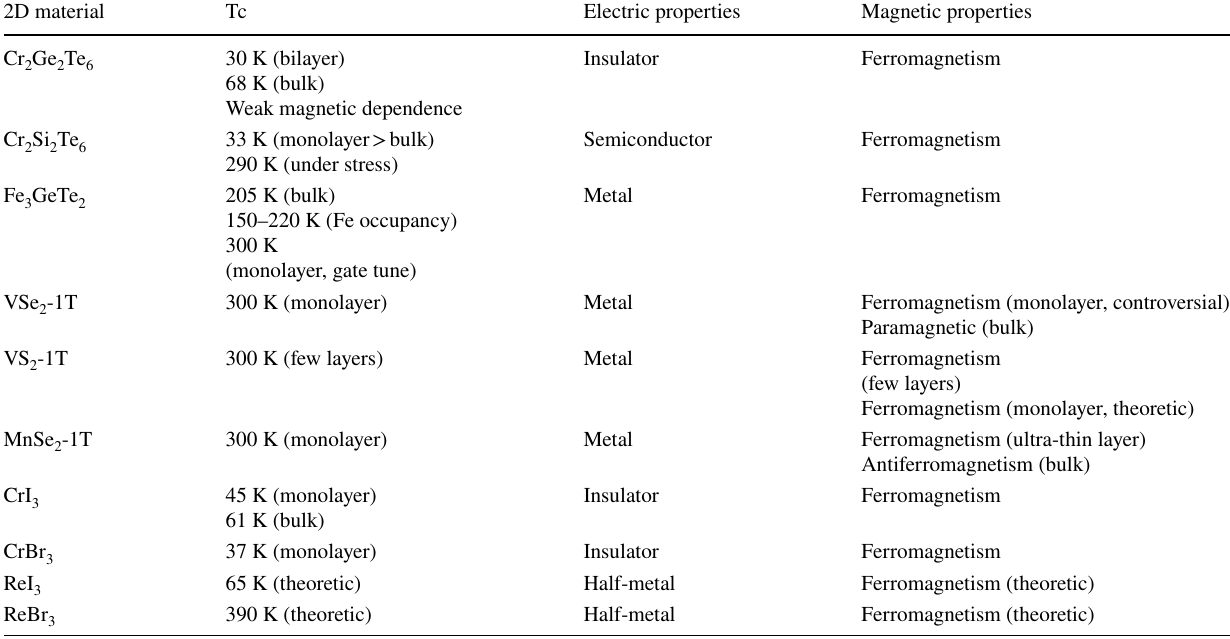
Table 1 Part of the 2D magnetic